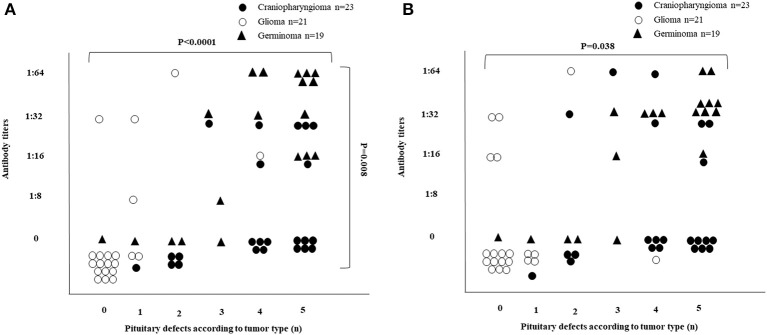
Distribution of APA and AHA in 63 patients with brain tumors based on tumor type and pituitary defects. (A) The presence of APA (P < 0.0001) and their titers (P = 0.008) were significantly associated with the number of pituitary defects (see details in the Results section). (B) The presence of AHA was significantly associated with the number of pituitary defects (P = 0.038), but not with their titer's level (P = 0.145) (see details in the Results section).